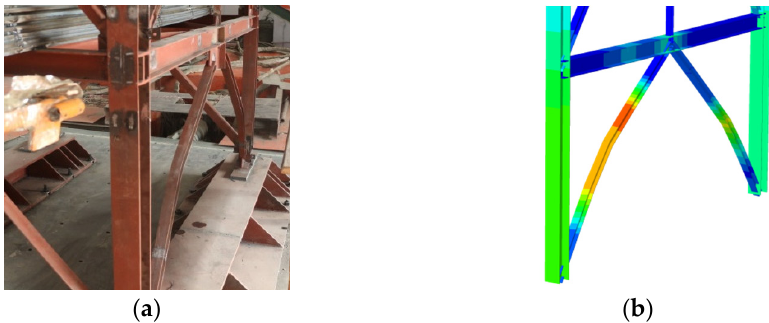
Figure 7. Comparison of specimen-failure phenomena: ( a ) test; ( b ) simulate.